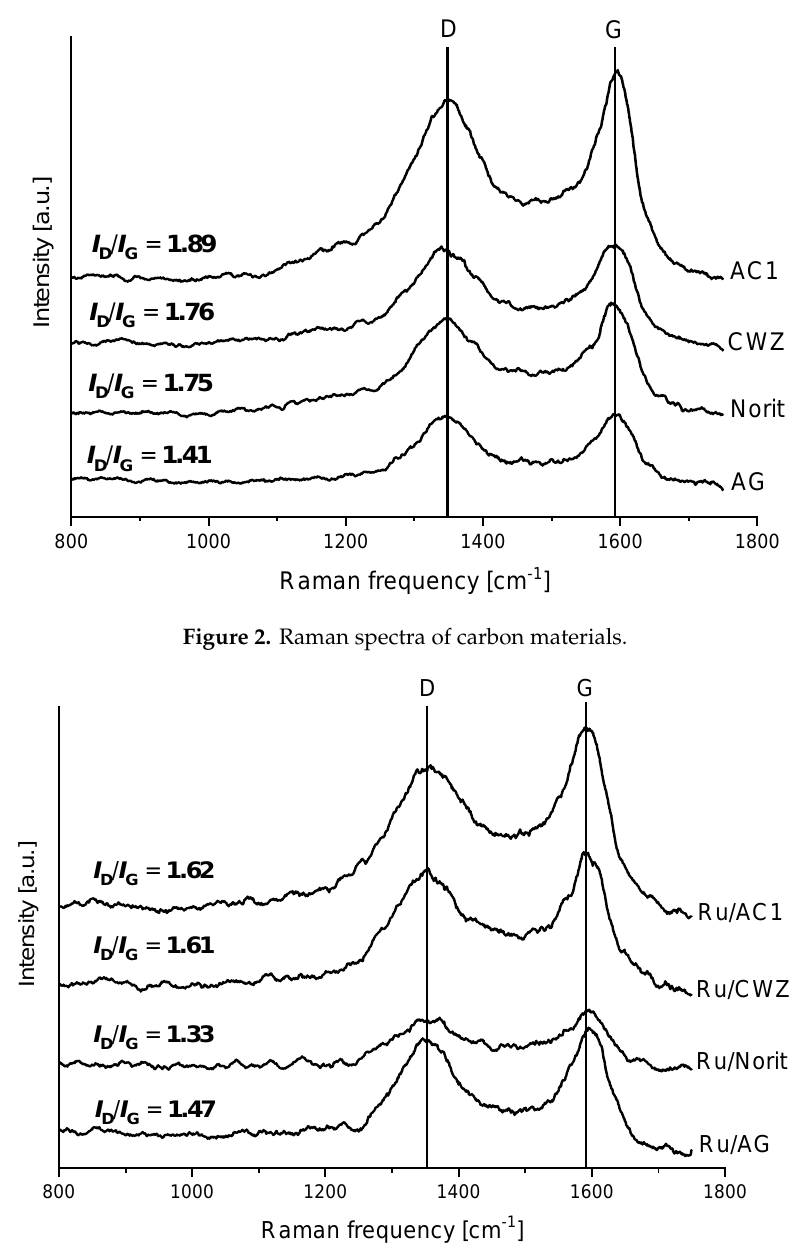
Figure 3. Raman spectra of ruthenium catalysts.